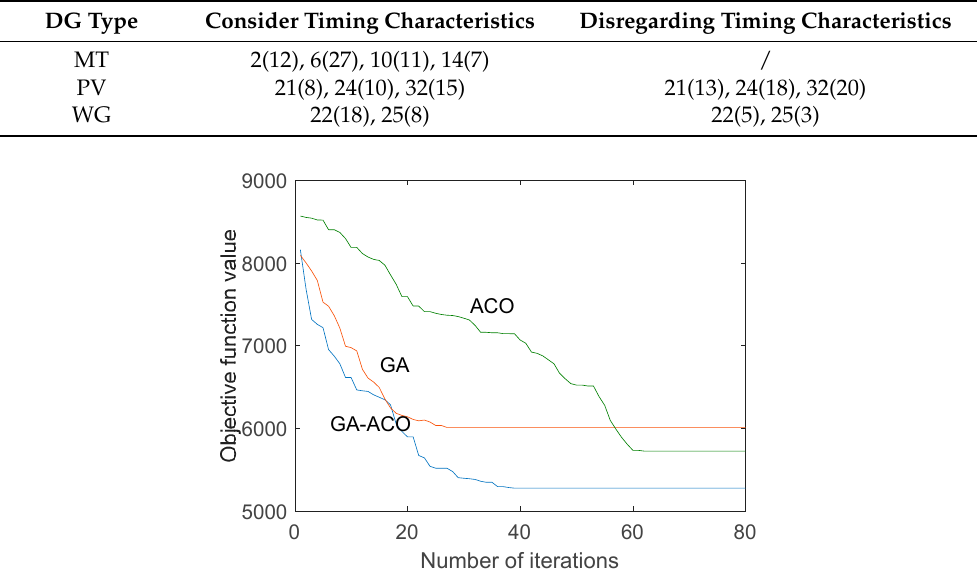
Figure 11. Optimization algorithm comparison chart considering load growth.